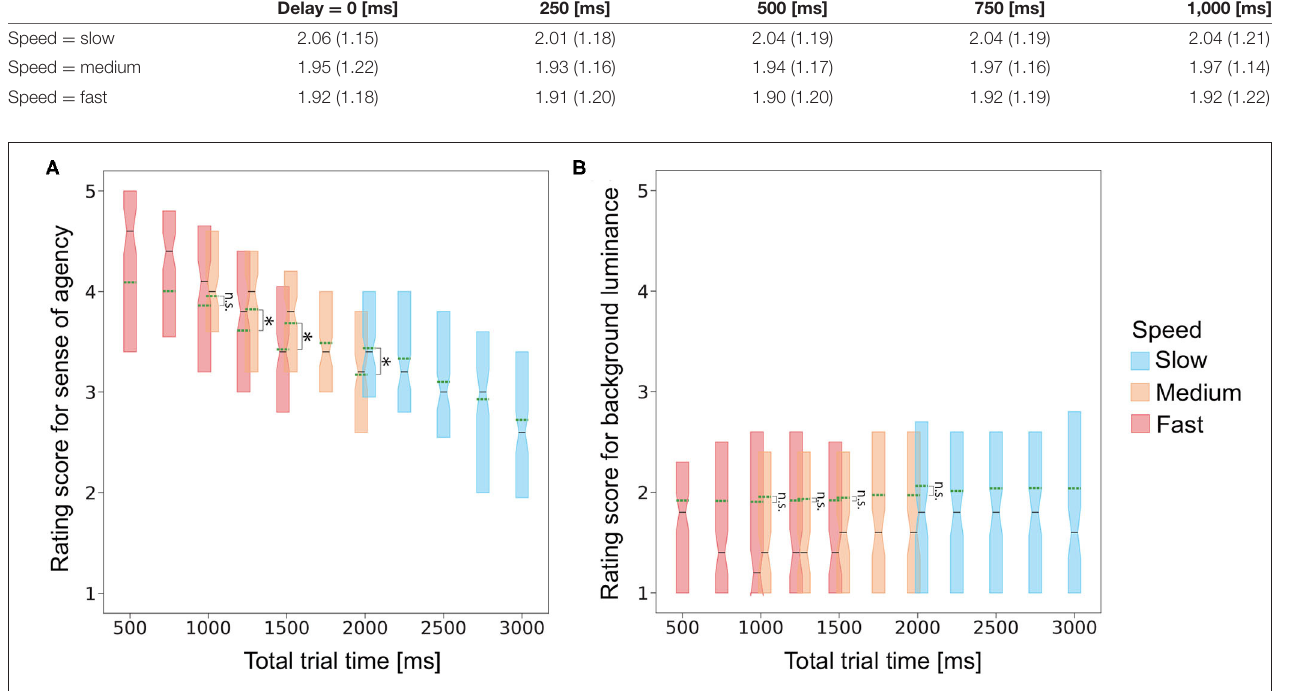
FIGURE 5 | Box plot of the (A) SoA and (B) background luminance rating scores as a function of total trial time. Green dashed lines denote the averaged values of the rating scores. The Asterisks and n.s. denotes that the difference was significant (i.e., Bonferroni corrected p < 0.05) and not significant (i.e., Bonferroni corrected p > 0.05),